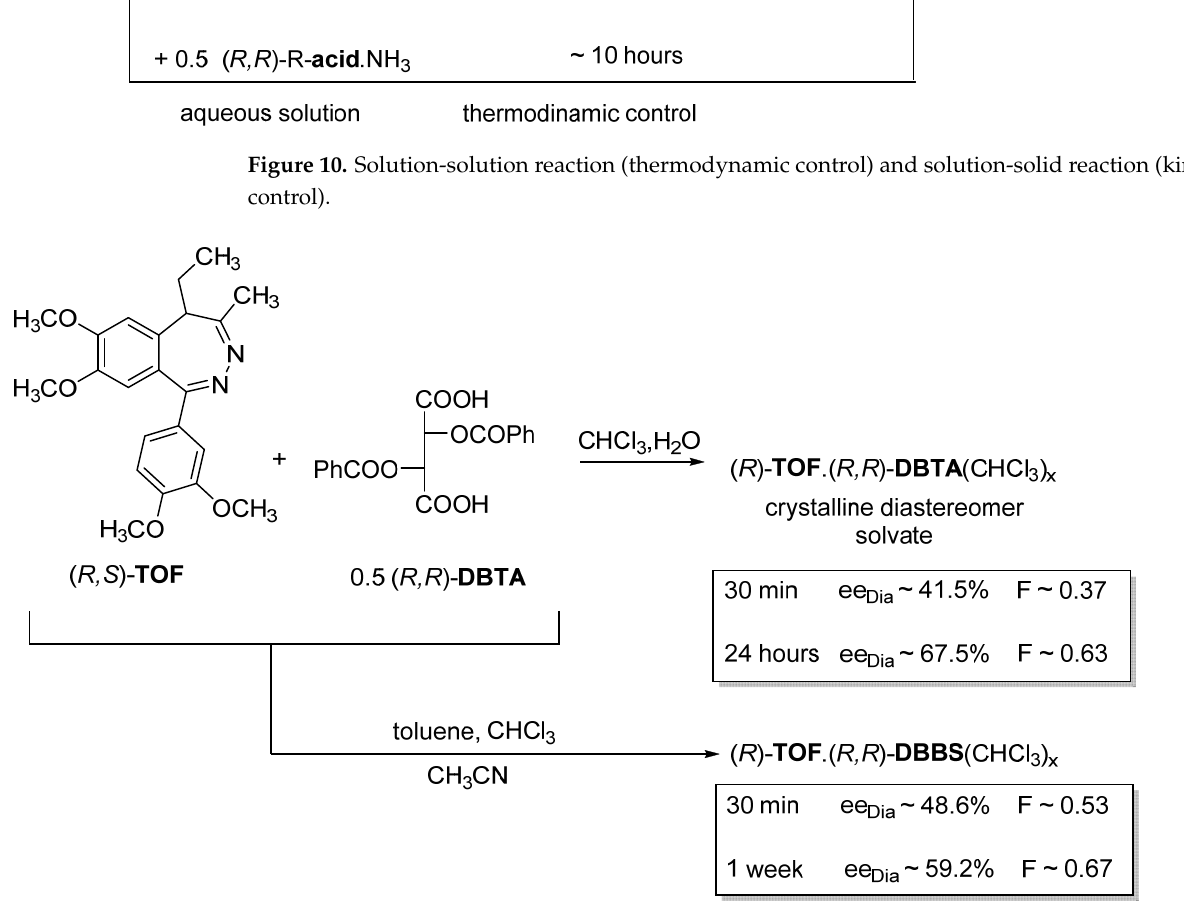
Figure 10. Solution-solution reaction (thermodynamic control) and solution-solid reaction (kinetic control).